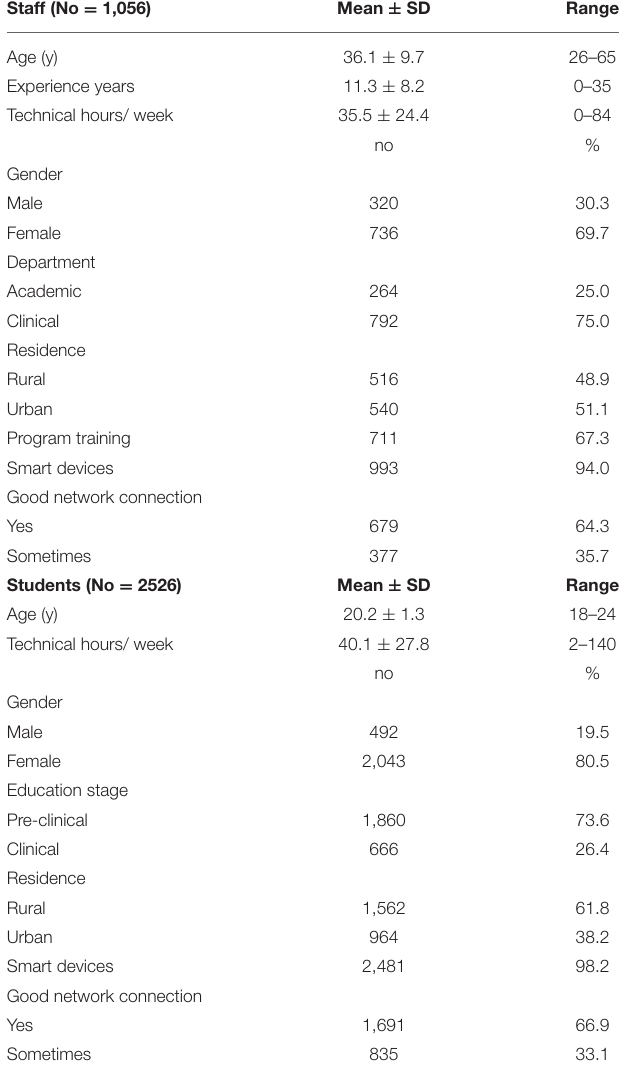
TABLE 1 | Characteristics of the studied staff and